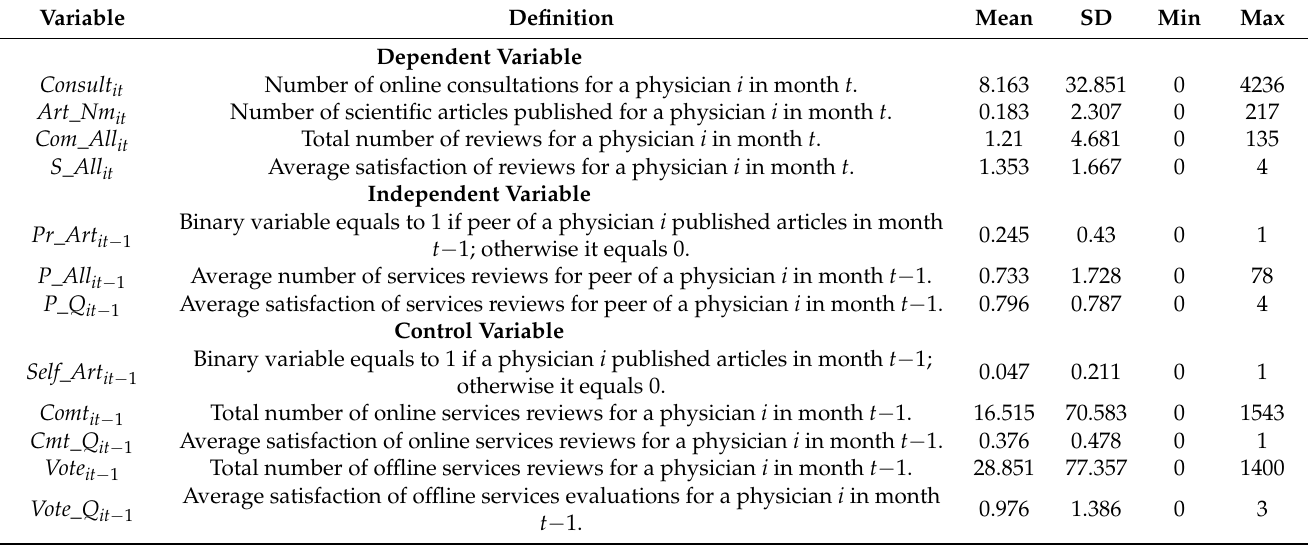
Table 1. Descriptive of